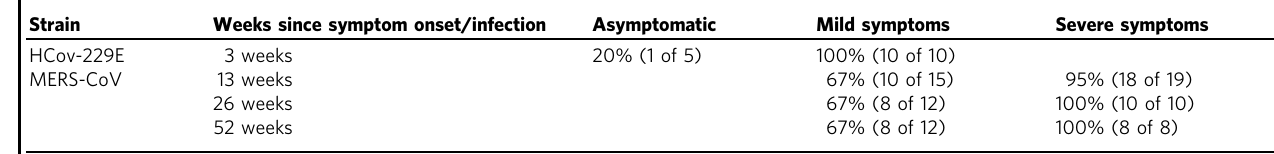
Table 2 Proportion of patients that had detectable antibodies, at different time points.